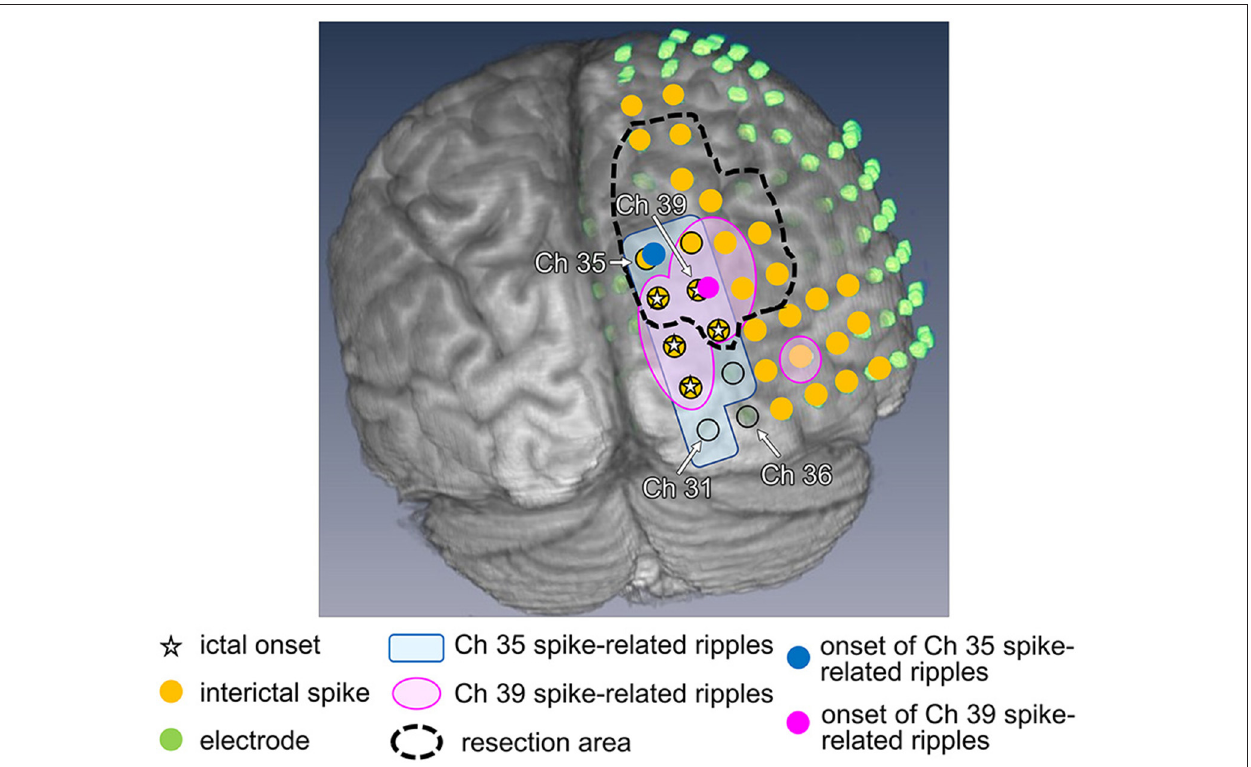
FIGURE 4 | Ripple onset in Ch 35 and Ch 39, and other findings in Patient 1. Spike-related ripples of Ch 35 and Ch 39 (light pink and light blue, respectively), ripple onset in Ch 35 and Ch 39 (filled pink circles and filled blue circles, respectively), ictal onset (star), interictal spike (filled yellow circle), placed electrode (filled green circle), and the resection margin (black dotted line) are shown. The spike-related ripples of each channel propagated around the ictal onset area and had a narrower distribution than the spikes. Ch 35 is not estimated as the ictal onset, but rather as the ripple onset. Ch 39 was estimated as both ictal and ripple